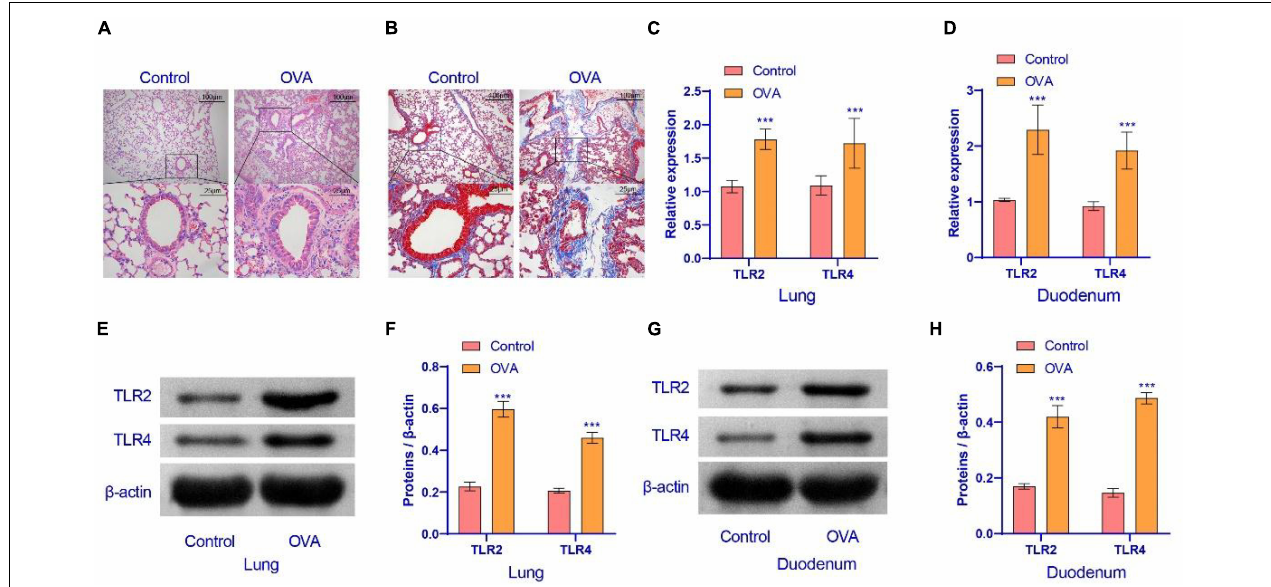
FIGURE 1 | Airway inflammation and TLR2/TLR4 expression in the lung of asthma mice. (A) HE staining were performed on the lung tissues of mice. (B) Masson staining was performed on the lung tissues of mice. (C,D) qRT-PCR was used to detect the expression of mRNA. The level of TLR2/TLR4 mRNA was suppressed in the OVA group. (E–H) Western blot was used to measure the expression of proteins. The expression of TLR2/TLR4 protein was raised in the OVA group. up: × 100, scale bar = 100 µ m; down: × 400, scale bar = 25 µ m. ***Compared with the control group, P < 0.001. Unpaired t -test was utilized for the comparison between two groups. n = 5 for each group.